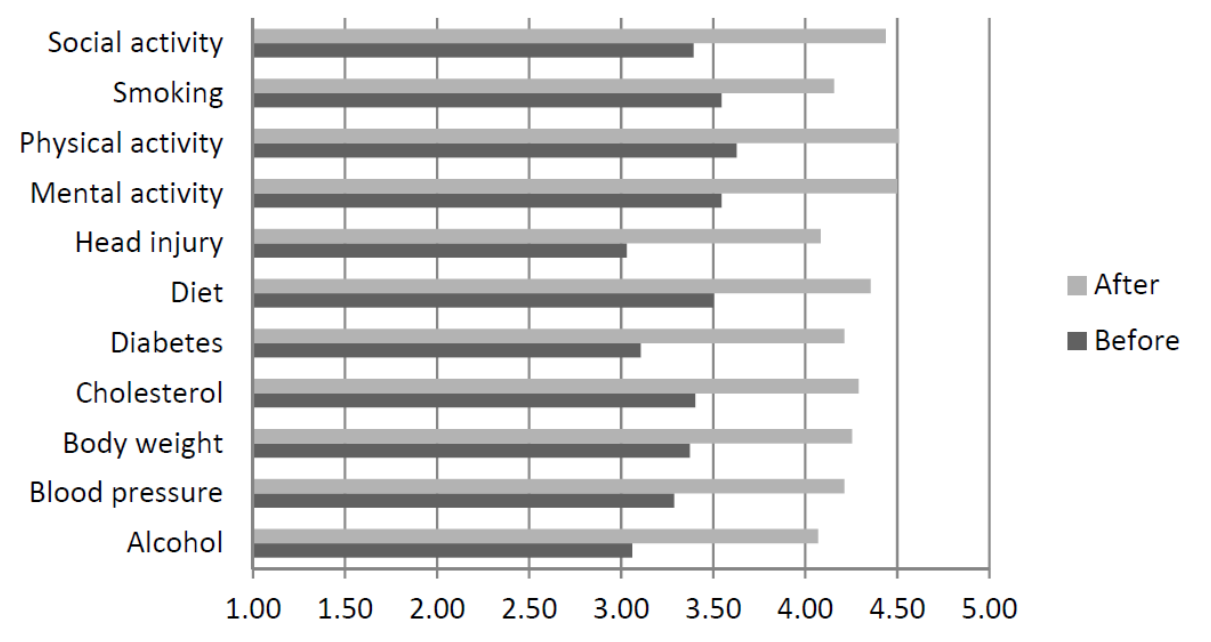
Figure 3. Mean ratings of importantance of monitoring behavior in relation to risk or protective factors before and after visiting the Mind your Mind website (n=67). Ratings: 1=not at all; 2=only mildly; 3=somewhat; 4=quite; 5=very